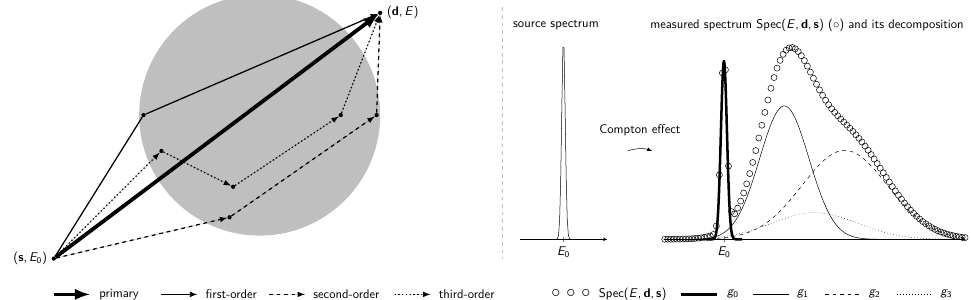
Figure 2. ( Left ) Illustration of the multiple scattering—the detector d measures photons of energy E that have not been scattered (primary) as well as scattered at different orders (here 1, 2 and 3). ( Right ) a schematic spectrum of the detector ( ◦ ) is illustrated via its decomposition in terms of type of scattered data and depicts the response to a monochromatic source due to the Compton